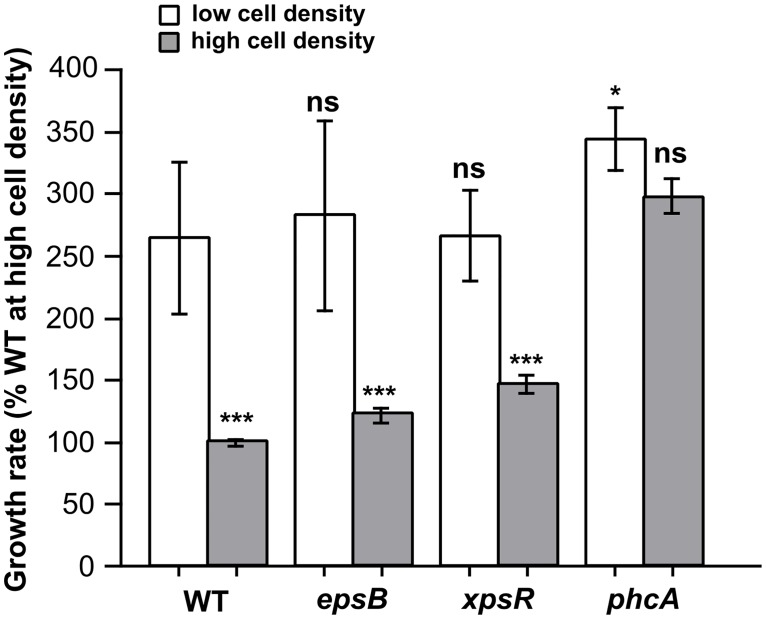
The restriction of growth rate observed for the wild-type strain compared to regulatory mutants is cell-density dependent.Growth rate of the strains GRS825 (Δeps), GRS574 (xpsR mutant) and GMI1605 (phcA mutant) compared to the wild-type strain at low cell density (white bars) and high cell density (grey bars). Cells were cultivated in microplates containing minimal medium supplemented with L-glutamate. Errors bars are 2*σ (95% data dispersion), n = 6 to 9 biological replicates. Statistical differences were tested in comparison with the wild-type value at low cell density; significance level (Student-test): ns, not significant; *, p-value <0.05; **, p-value <0.01; ***, p-value <0.001.